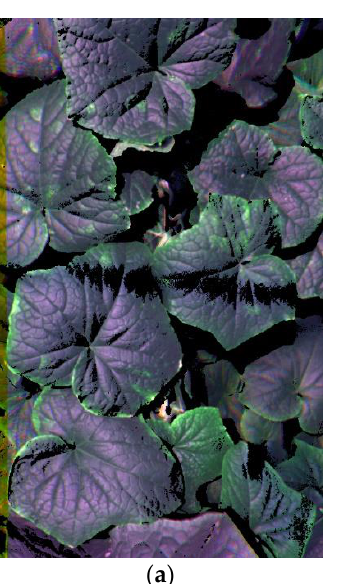
( o ) PMVI-2 Figure 6. Comparisons between an aligned RGB close-range image and related vegetation index images from Table 2. ( a ) RGB composite; ( b ) Simple Ratio; ( c ) Normalized Difference Vegetation Index; ( d ) Difference Vegetation Index; ( e ) En- hanced Vegetation Index; ( f ) Soil-Adjusted Vegetation Index (L is equal to 0.5); ( g ) Optimized Soil-Adjusted Vegetation Index; ( h ) Optimized Soil-Adjusted Vegetation Index 2; ( i ) Green Chlorophyll Index; ( j ) Green Normalized Difference Vegetation Index; ( k ) Redness Index; ( l ) Red-Edge Chlorophyll Index; ( m ) Red-Edge Normalized Difference Vegetation Index; ( n ) Powdery Mildew Vegetation Index; ( o ) Powdery Mildew Vegetation Index 2.